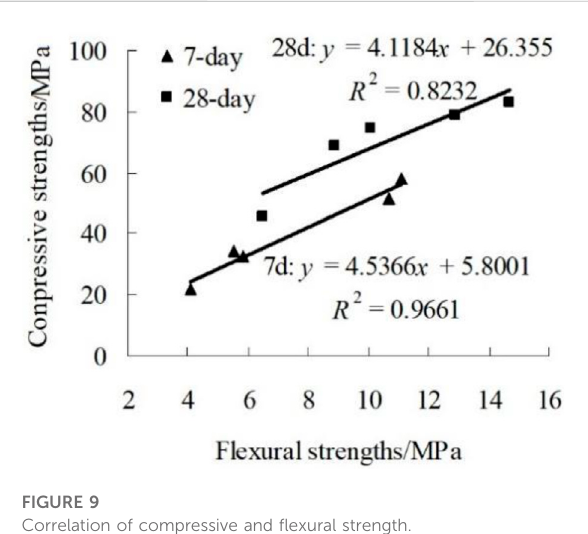
FIGURE 9 Correlation of compressive and fl exural